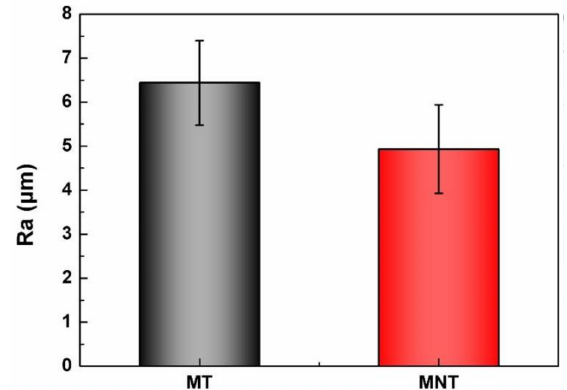
Figure 4. The roughness of MT and MNT coatings.